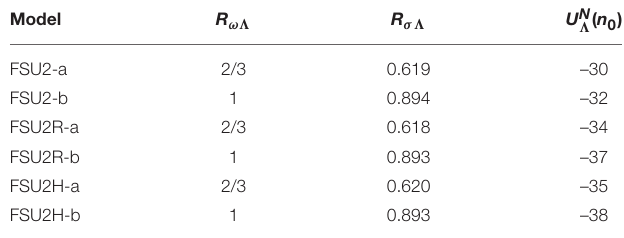
TABLE 2 | Density transitions in the pasta phase, n d considered in this work. Model